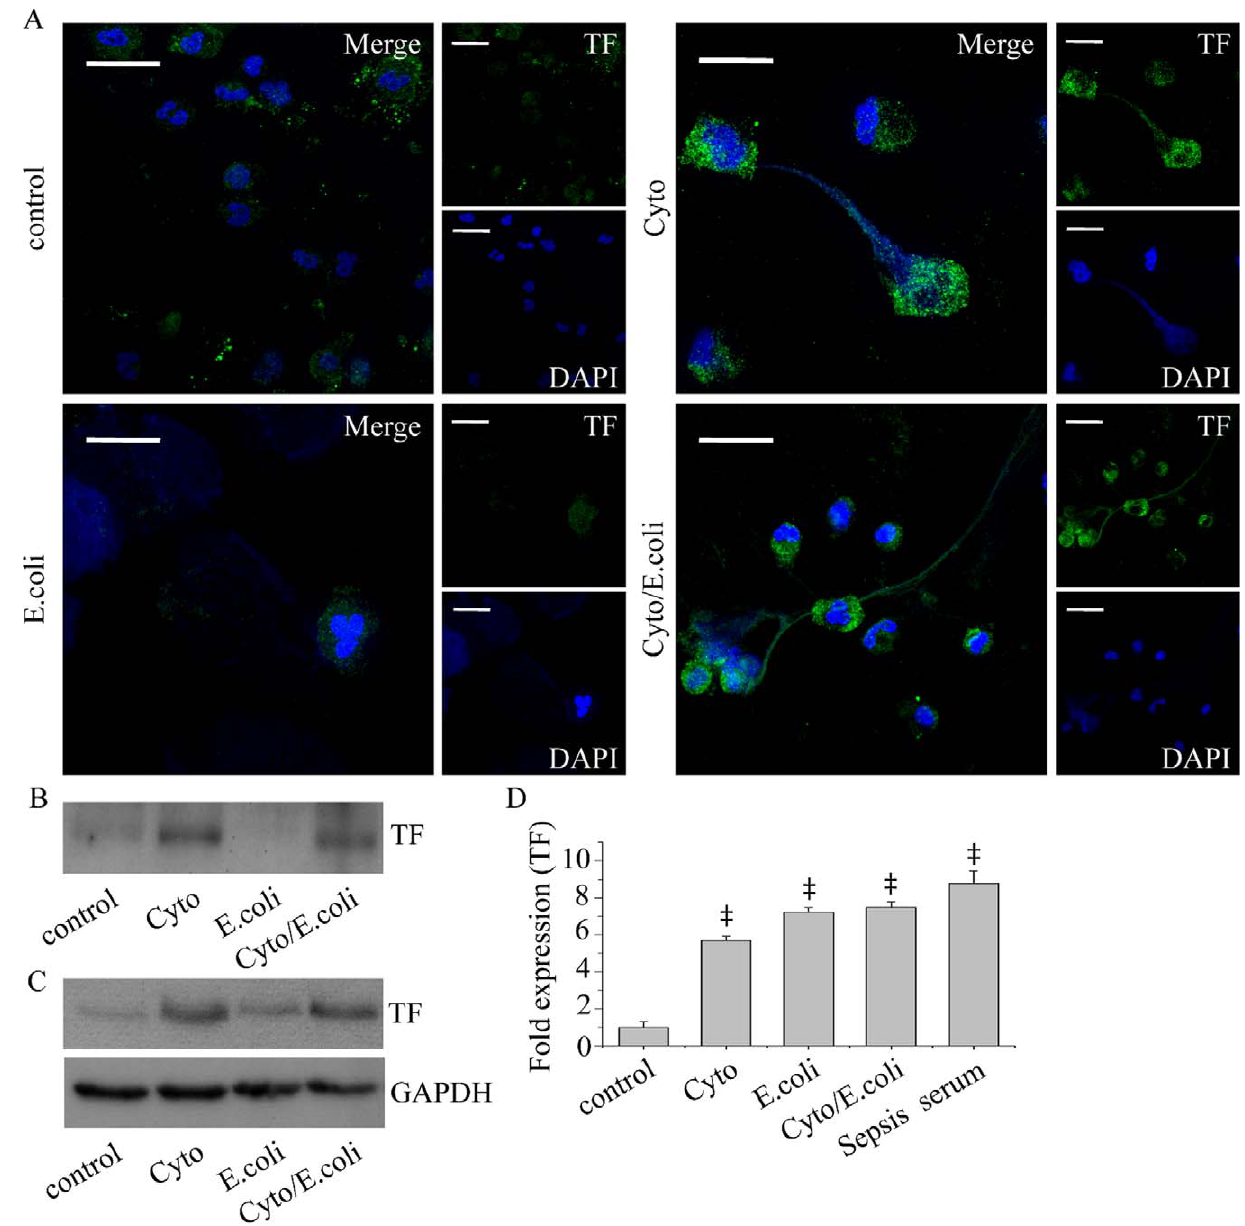
Figure 3. TF localization in NETs after invitro stimulations. (A) Detection of TF in NETs released by control neutrophils treated with TNF- a , IL- 1 b and G-CSF (Cyto), or E. coli alone (E. coli) or E. coli in the presence of the aforementioned cytokines (Cyto/E. coli), as assessed by confocal microscopy (z stack analysis, 0.3 m m per plane). One representative out of four independent experiments is shown (DNA labeled with DAPI; blue, anti- TF monoclonal antibody; green) (original magnification 600 6 ). Scale bar represents 10 m M . (B) TF levels in NET-isolated proteins and (C) cell lysates, assessed by immunoblotting. One representative out of four independent experiments is shown. (D) TF mRNA levels in untreated control neutrophils (control) or treated with TNF- a , IL-1 b and G-CSF (Cyto) or E. coli alone (E. coli) or in the presence of the aforementioned cytokines (Cyto/E. coli) or serum from patients with sepsis (Sepsis serum). Data are representative of four independent experiments and presented as mean 6 SD. ( { P , .05).